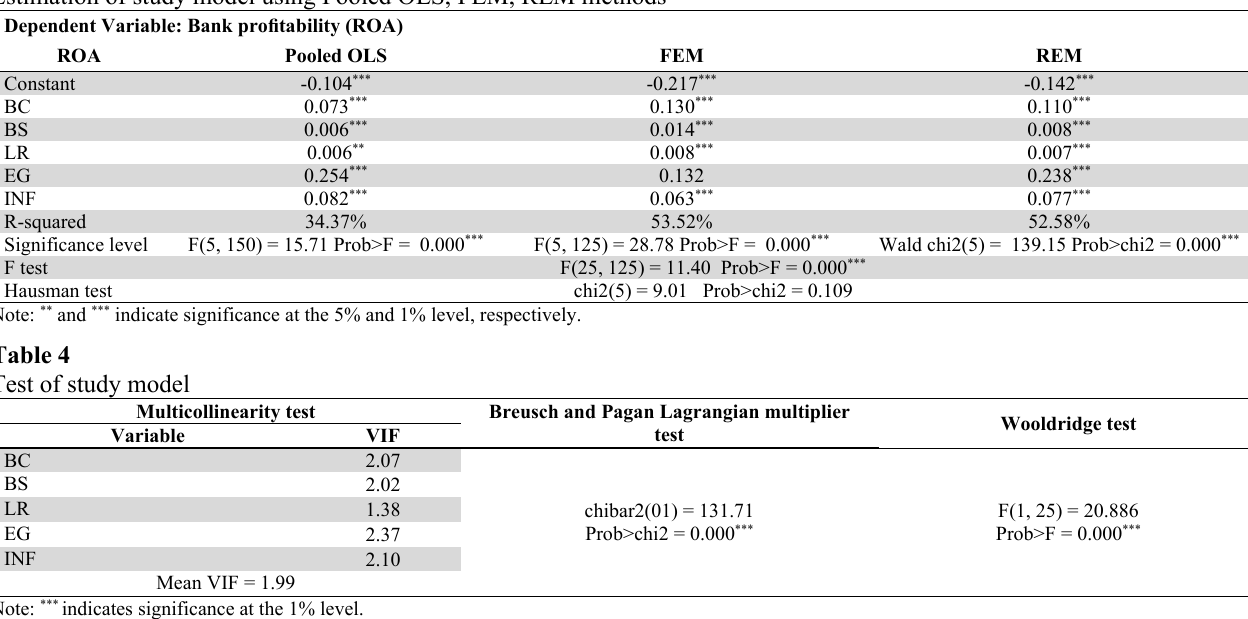
Estimation of study model using Pooled OLS, FEM, REM methods